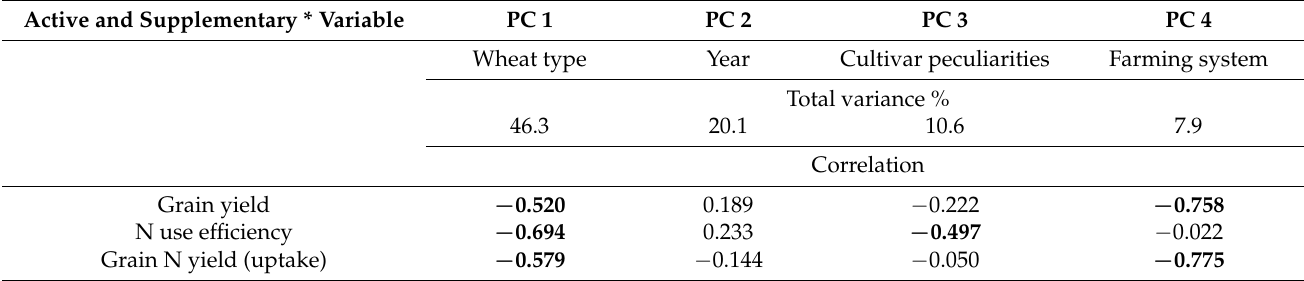
Table 4. Correlations between the first four principal components and 30 winter wheat grain yield and quality traits for calculation representing 2 waxy and 2 non-waxy winter wheat cultivars grown in low-input and intensive farming systems under 2-year conditions (n =